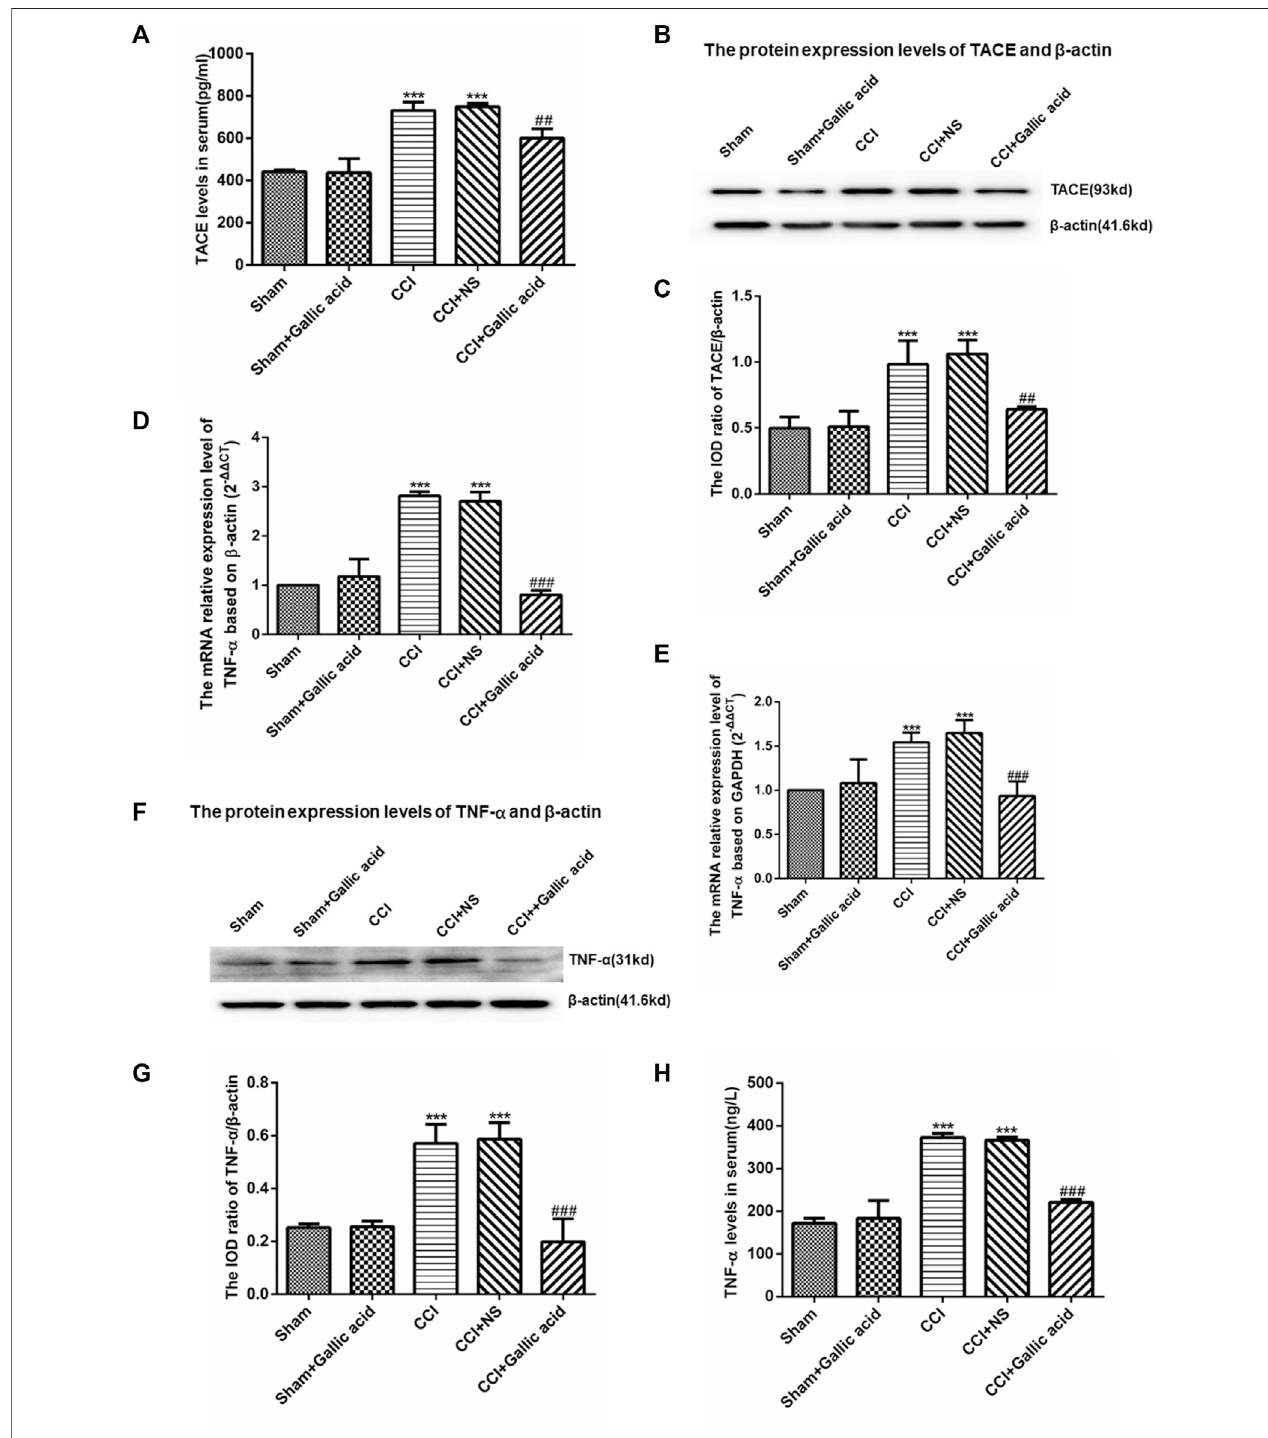
FIGURE3|EffectofgallicacidontheexpressionofTACEandTNF- α .(A). TheexpressionofTACEinserumwasdetectedbyenzyme-linkedimmunosorbent assay (F (4, 10) (cid:2) 89.68, p < 0.001). (B). Detection of the TACE and β -actin protein expression in the DRG by Western blotting. (C). The relative protein expression of TACE(F(4,10) (cid:2) 24.12, p < 0.001). (D). TheexpressionofTNF- α mRNAwasdetectedbyqRT-PCRusing β -actinasthehousekeepergene(F(4,10) (cid:2) 174.2, p < 0.001). (E). The expression ofTNF- α mRNA was detected by qRT-PCR using GAPDH asthe housekeeper gene (F (4, 10) (cid:2) 22.63, p < 0.001). (F). In the DRG, TNF- α and β -actin protein expression wasdetectedbyWesternblotting. (G) . Therelative protein expression ofTNF- α (F(4, 10) (cid:2) 33.47, p < 0.001). (H). The expression ofTNF- α in serum was detected by enzyme-linked immunosorbent assay (F (4, 10) (cid:2) 212.2, p < 0.001). One-way ANOVA was used to detect the expression of TACE and TNF- α . Each group consisted of eight rats. Data are presented as mean ± SEM. *** p < 0.001 versus the Sham group, ### p < 0.001 versus the CCI group.